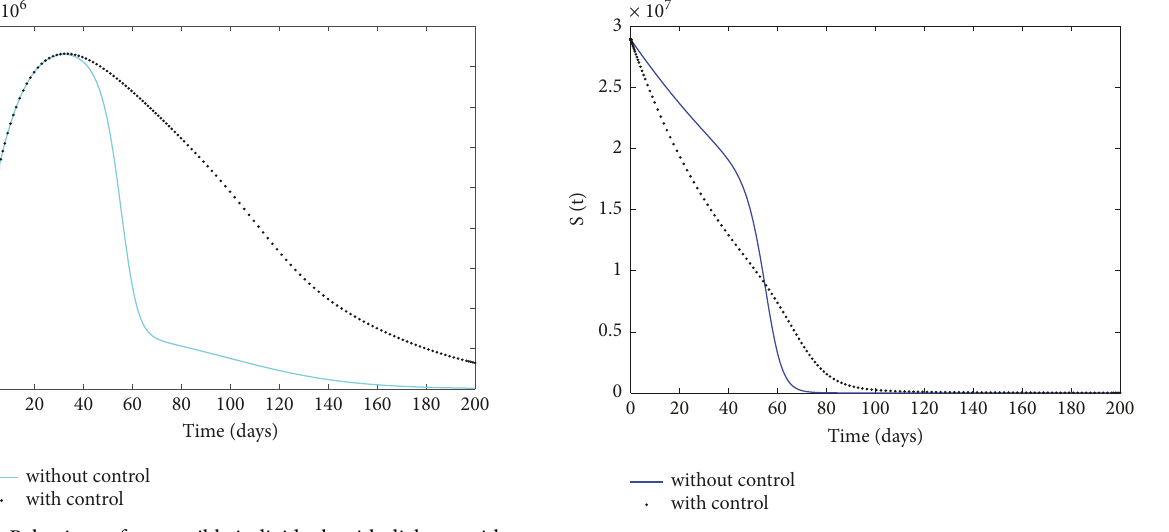
Figure 17: Behaviour of the susceptible population with and without vaccination control.